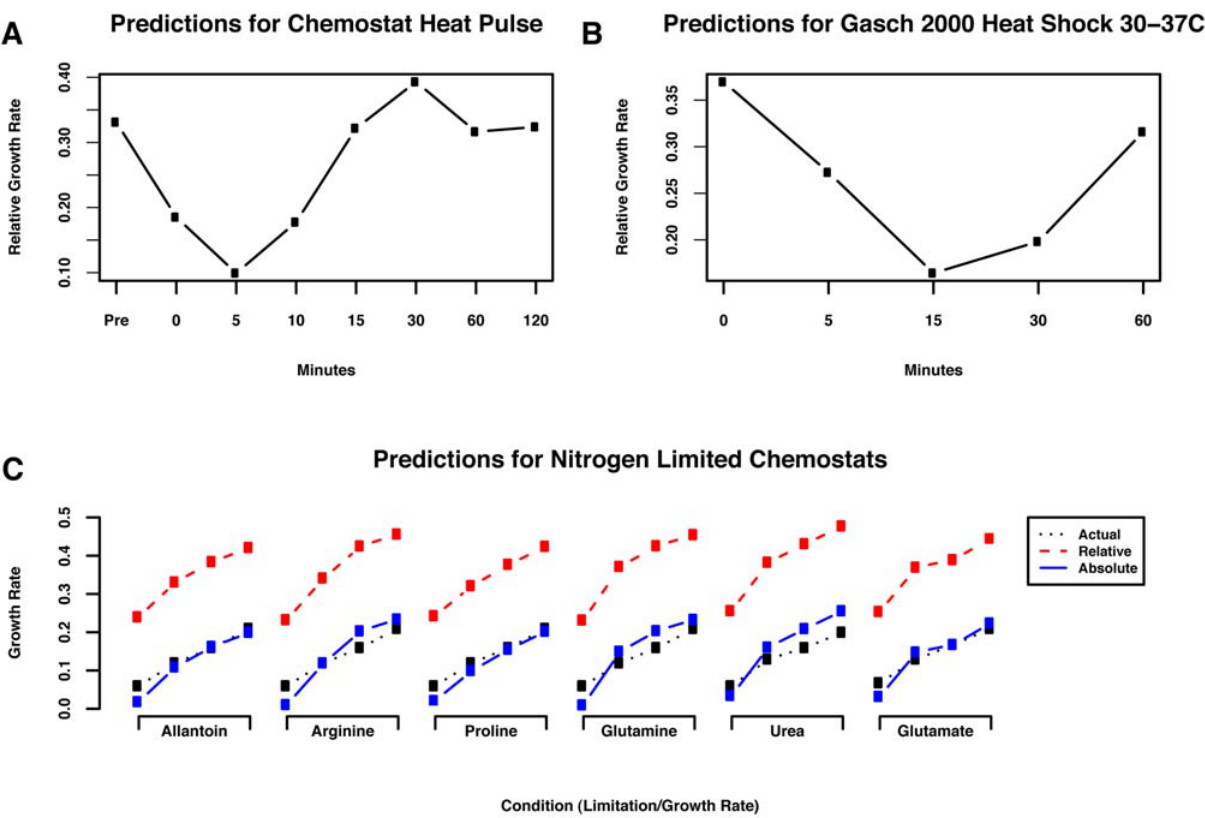
Figure 4. Predicted growth rates for S.cerevisiae gene expression datasets. Our model of the growth rate transcriptional response can be used to predict the growth rate of a cellular culture from gene expression data, robust to the originating biological conditions, growth regime, and experimental platform. Here, we apply the model to three selected data sets to infer relative and absolute growth rates. (A) A brief ( , 30 s) heat pulse was administered to a steady state chemostat culture immediately before time zero, and gene expression was assayed with an expression time course (see Figure S1 and Table S1). The relative growth rates inferred from this data show an abrupt departure from steady state growth, followed by a return to steady state (including a brief regulatory overshoot). Our predictions monitor these changes in growth rate at an instantaneous time scale ( , 5 m) inaccessible by standard experimental assays for growth rate. (B) Predicted growth rates for a portion of the environmental stress response data [6], assaying the response to a 30–37 u C heat shock. Our model captures the cessation and resumption of growth induced by the stress, even for a batch culture in which the growth rate is not fixed a priori. (C) A collection of 24 chemostats were run at four growth rates (0.05 hr 2 1 through 0.2 hr 2 1 ) and limited on six different nitrogen sources. Using only expression data from each condition, our model predicts accurate relative growth rates. However, when provided with the known growth rate for a single condition, the model is additionally able to infer absolute growth rates for all other data sets sharing that condition’s mRNA reference channel. Note that the actual growth rate is measured empirically and thus deviates slightly from an ideal straight line due to technical variation in the growth equipment.